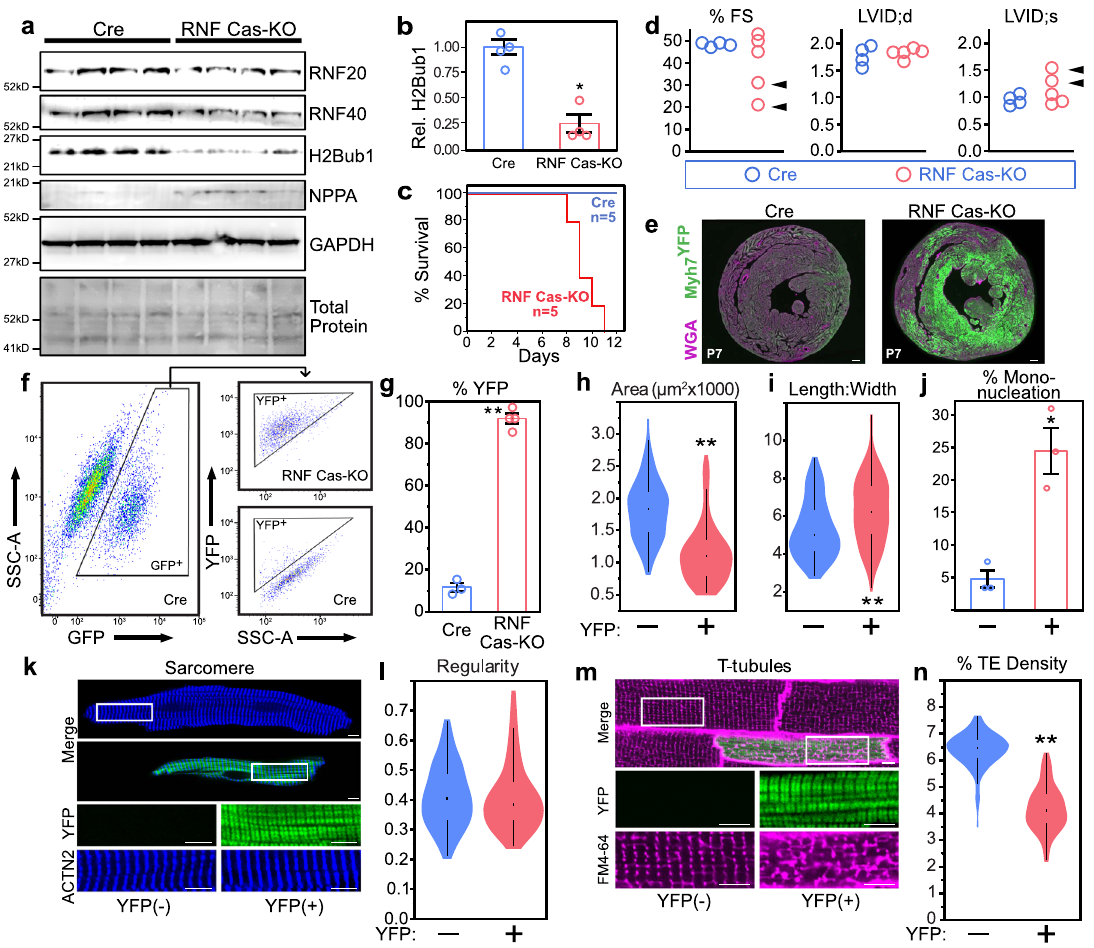
Fig. 3 Characterization of CASAAV-RNF20/40 and RNF20/40-depleted CMs. a – d Neonatal pups were treated with CASAAV-RNF20/40 (RNF Cas- KO) at a dose that transduced most CMs. Western blotting of ventricular apexes ( a ) was performed to measure protein levels of RNF20, RNF40, H2Bub1, and NPPA, with GAPDH internal control. RNF20, RNF40, and H2Bub1 were depleted, whereas NPPA was upregulated. n = 4 mice per group. Quanti fi cation of H2Bub1 ( b ) showed signi fi cant 74% reduction ( P = 0.0007), consistent with reduced RNF20/40 ubiquitin ligase activity. Reduction in tissue samples with multiple cell types underestimates changes in cardiomyocytes. Survival curve ( c ) demonstrated death of juvenile RNF Cas-KO mice in the majority of CMs. At P7, before the onset of lethality, echocardiography ( d ) showed that a subset of mice (arrowheads) exhibited cardiac dysfunction (reduced fractional shortening percentage and increased LV internal diameter at end systole). e Sections of RNF Cas-KO hearts ( n = 3 mice) at P7 showed dramatic upregulation of Myh7 YFP compared with controls ( n = 3 mice). Scale bars = 200 μ m. f – n In order to avoid non-cell-autonomous secondary effects of heart failure, CASAAV-RNF20/40 was administered to newborn R26 Cas9-GFP/ + ; Myh7 YFP/ + pups at a mosaic dose. Analysis was performed at P28. f Representative fl ow cytometry analysis. Cells were gated on GFP (transduction marker) and then on YFP. g Quanti fi cation of YFP + transduced CMs. RNF Cas-KO markedly increased the fraction of transduced CMs that retained Myh7 YFP expression at P28 (92% of CASAAV-RNF20/40-transduced CMs, compared with 13.5% of AAV-Cre; P < 0.0001). h – n Analysis of CM maturation. RNF Cas-KO CMs were markedly smaller than controls ( h ; P < 0.0001), with a moderate increase in length-to-width ratio ( i; P = 0.0002). j These RNF20/40-depleted CMs had increased mononucleation ( P = 0.0207). k – l However, sarcomere organization appeared unperturbed. In total 89 YFP- and 93 YFP + CMs were randomly selected from three mice in equal proportions for quanti fi cation. m , n T-tubules were markedly disrupted, as determined by optical sectioning of freshly isolated, FM4 – 64-perfused hearts followed by quantitative analysis of T-tubule transverse element (TE) density ( P < 0.0001). In total 79 YFP- and 69 YFP + CMs were randomly selected from three mice in equal proportions for quanti fi cation. Collectively, these phenotypes observed in RNF Cas-KO CMs indicate that maturation is impaired. Source data are provided as a Source Data fi le. Scale bars in k and m = 5 μ m. Violin plots: shape indicates data distribution; point, median; whiskers, starts at quartile and extends 1.5 times the interquartile distance. Bar plots: error bars denote standard error. Two-tailed t-test: * P < 0.05, ** P < Transcriptional regulation of CM maturation by RNF20/40 . To mice with a mosaic dose of AAV-TnT-Cre at eight weeks of age and dissociated CMs for analysis at 12 weeks. Area, length, and measure the effect of RNF20/40 depletion on gene expression width of CMs were unaffected by mosaic RNF20 KO (Suppl. during maturation, we conducted transcriptional pro fi ling. Fig. 5j – l). In contrast, T-tubule organization was disrupted, with KO CMs demonstrating decreased transverse element density and vector containing Cre without gRNAs. At P28, hearts were dis- increased longitudinal element density (Suppl. Fig. 5m – p). These sociated and fl ow cytometry was used to recover YFP + CMs data indicate that RNF20 is necessary in adult CMs for transduced with CASAAV-RNF20/40 or control GFP + CMs maintenance of some features of maturation (T-tubules) but transduced with Cre. We analyzed the transcriptomes of each not others (size and overall morphology).